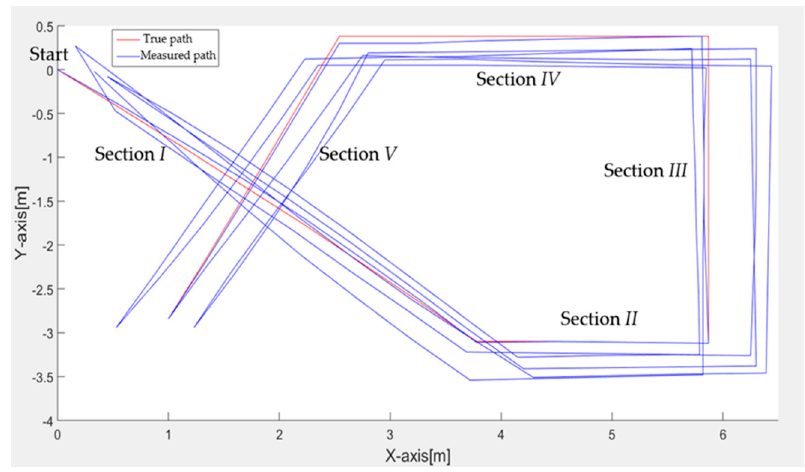
Figure 7. Test path for validation of PDR indoor localization.